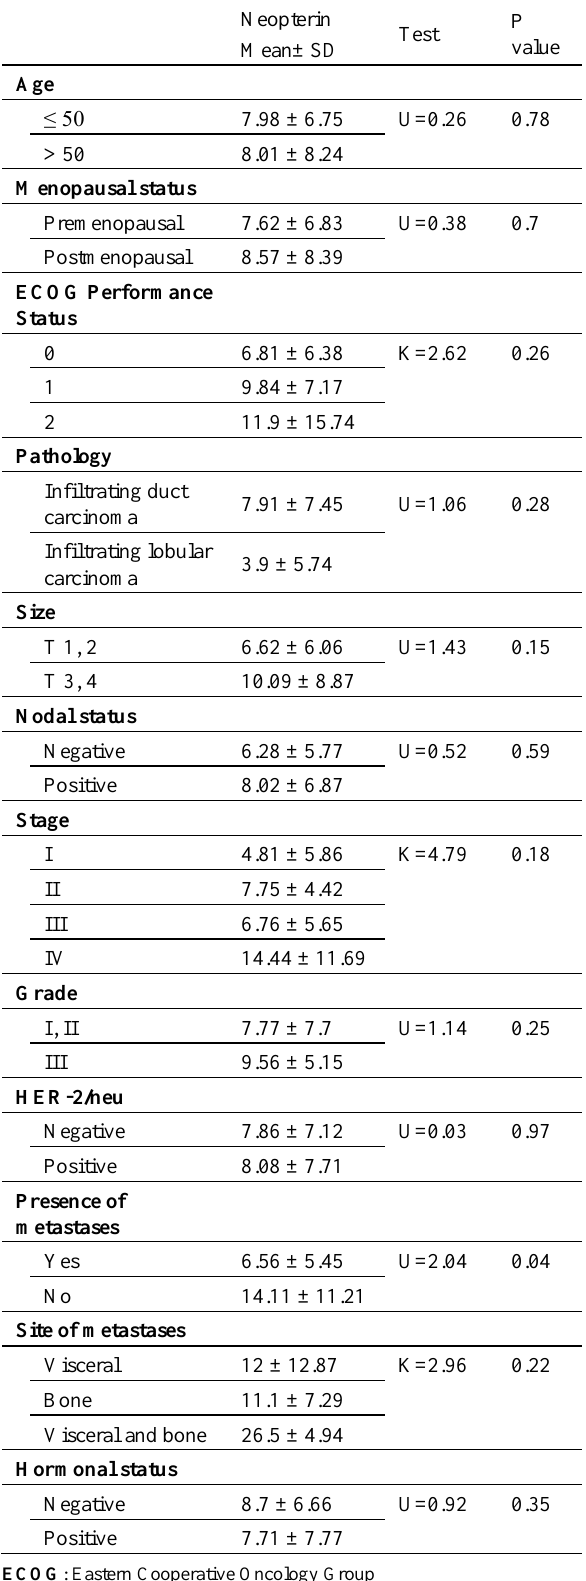
Table 3: The relation between mean serum neopterin levels and patients & disease